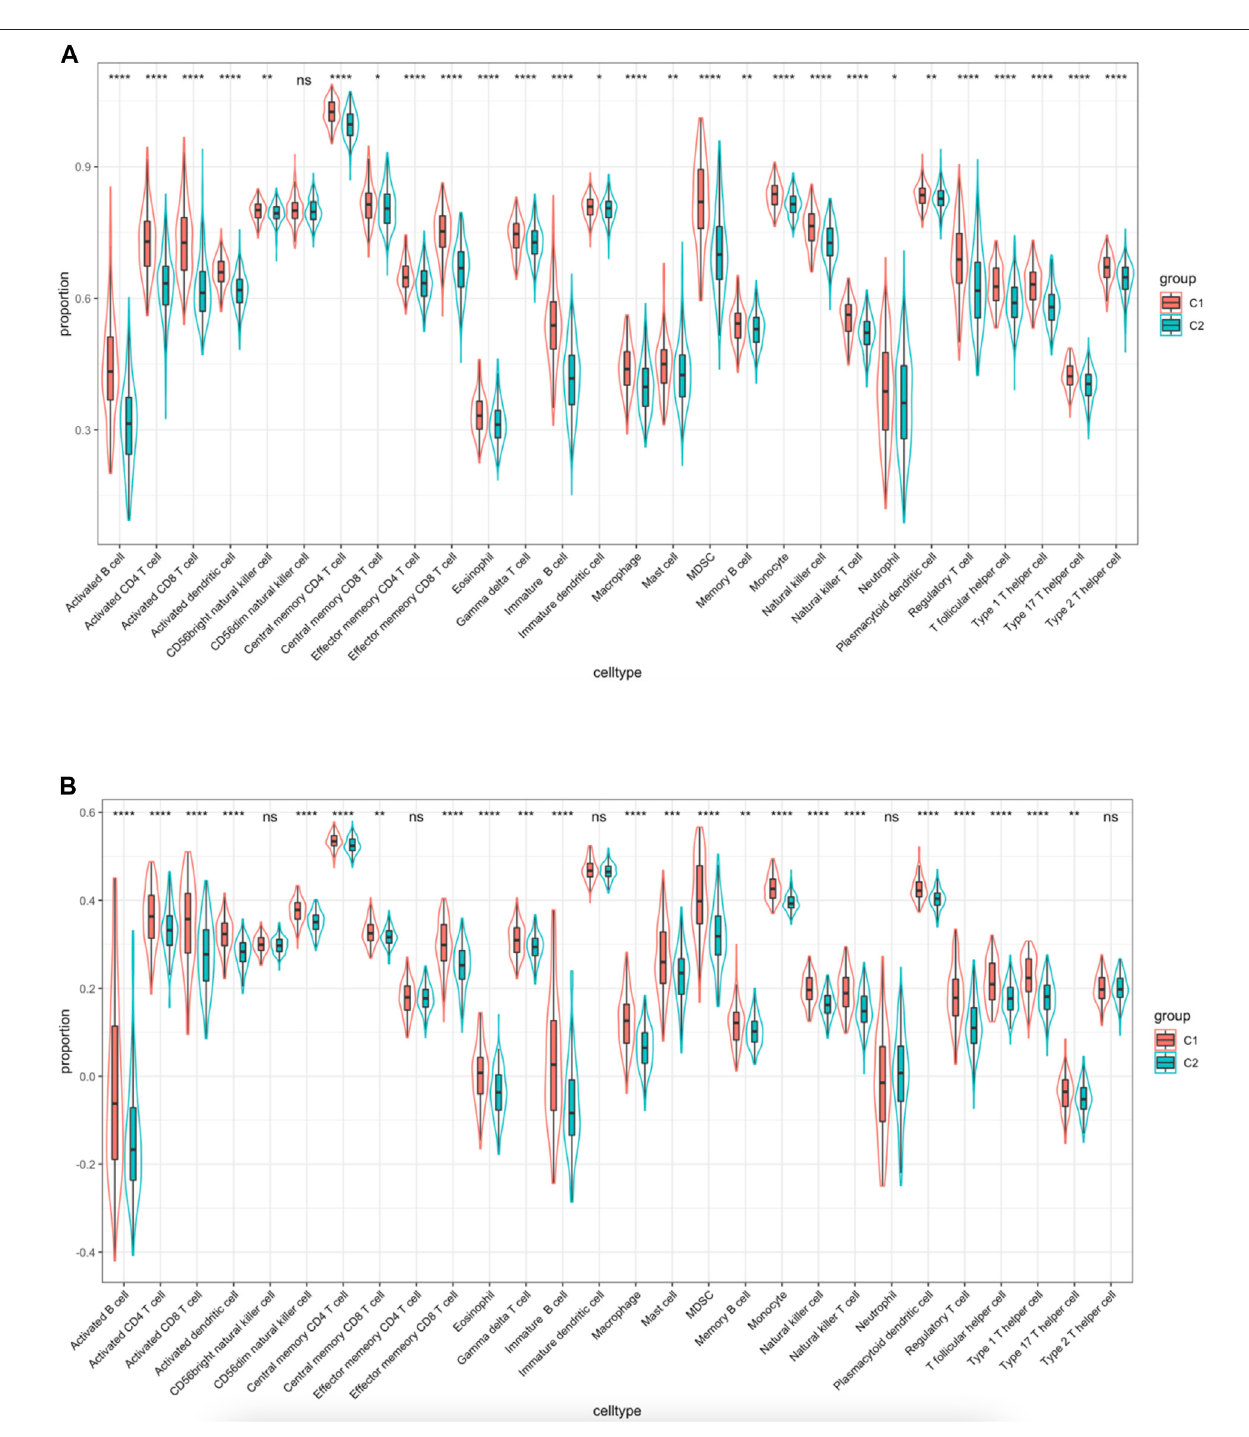
FIGURE 4 | NecroticScore in fl uences the tumor immune microenvironment in HNSCC. (A) Enrichment of each immune cell type in fi ltrating in high-score (C1) and low-score (C2) groups; from TCGA; the asterisk represents the different p values (* < 0.05; ** < 0.01; *** < 0.001, **** < 0.0001), C1 (170case), C2 (331cases). (B) Enrichmentofeachimmunecelltypein fi ltratinginhigh-score(C1)andlow-score(C2)groups;fromGSE65858;theasteriskrepresentsthedifferent p values(* < 0.05;** < 0.01; *** < 0.001, **** < 0.0001), C1 (115cases), C2 (155cases). (C) Differential expression of Immune checkpoint genes in C1 and C2 groups; from TCGA cohort; theasteriskrepresentsthedifferent p values(* < 0.05;** < 0.01;*** < 0.001,**** < 0.0001),C1(170case),C2(331cases). (D – K) CorrelationbetweenNecroticScoreand CD274, PDCD1, CD247, PDCD1LG2, CTLA4, TNFRSF9, TNFRSF4, and TLR9.